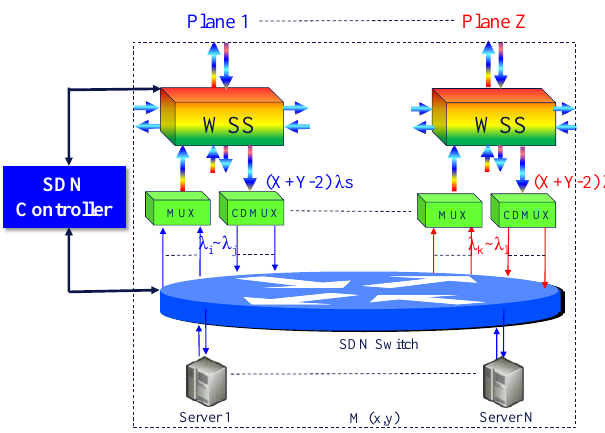
Figure 2. Multi-plane Torus topology optical tunnel switching network.